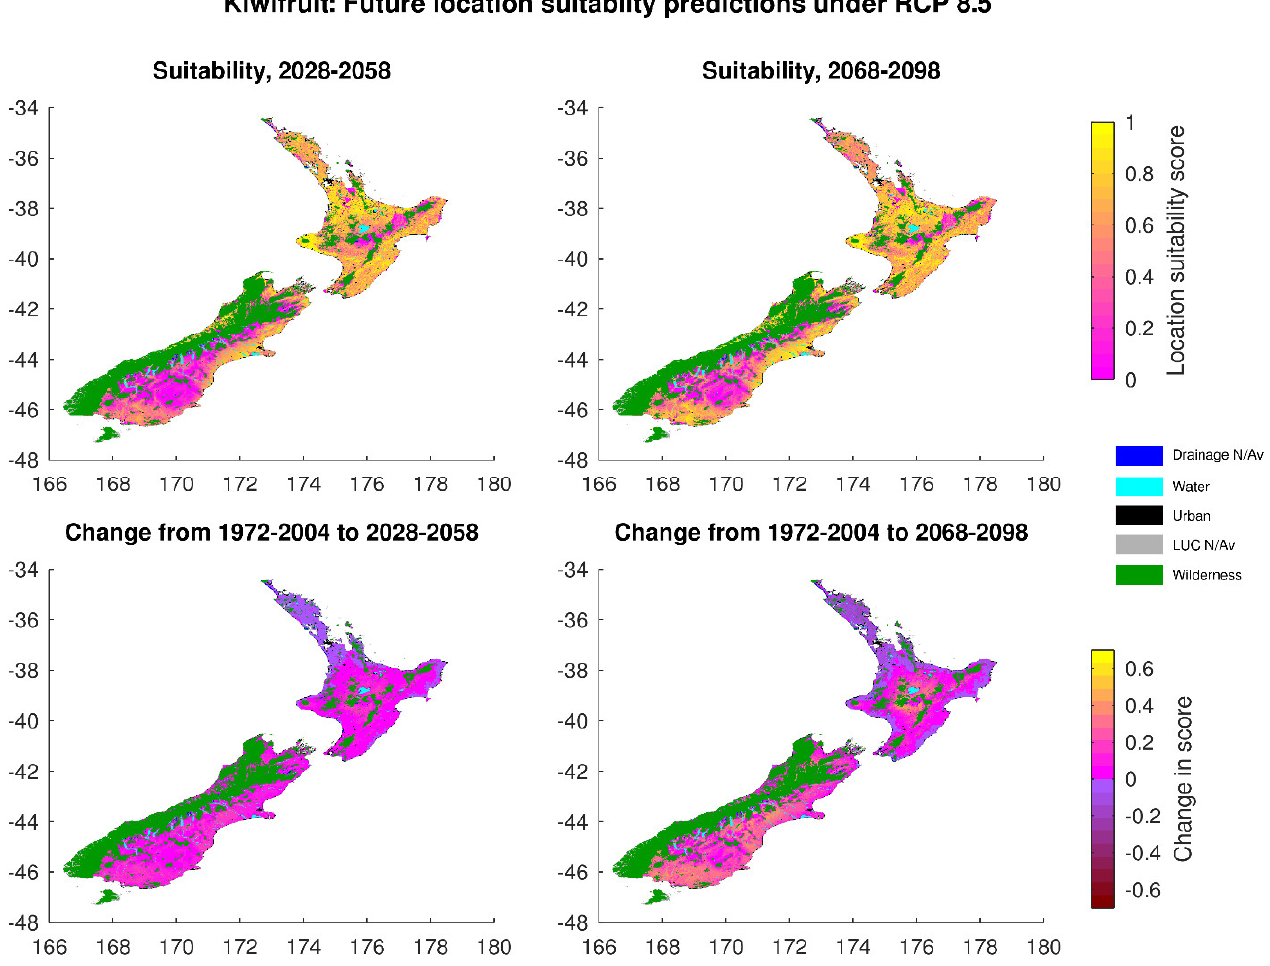
Figure 7. Kiwifruit: projected location suitability ( top panels) and projected changes in location suitability from the historic period ( bottom panels) for the mid-century ( left panels) and late-century ( right panels) in New Zealand under Representative Concentration Pathway (RCP) 8.5.